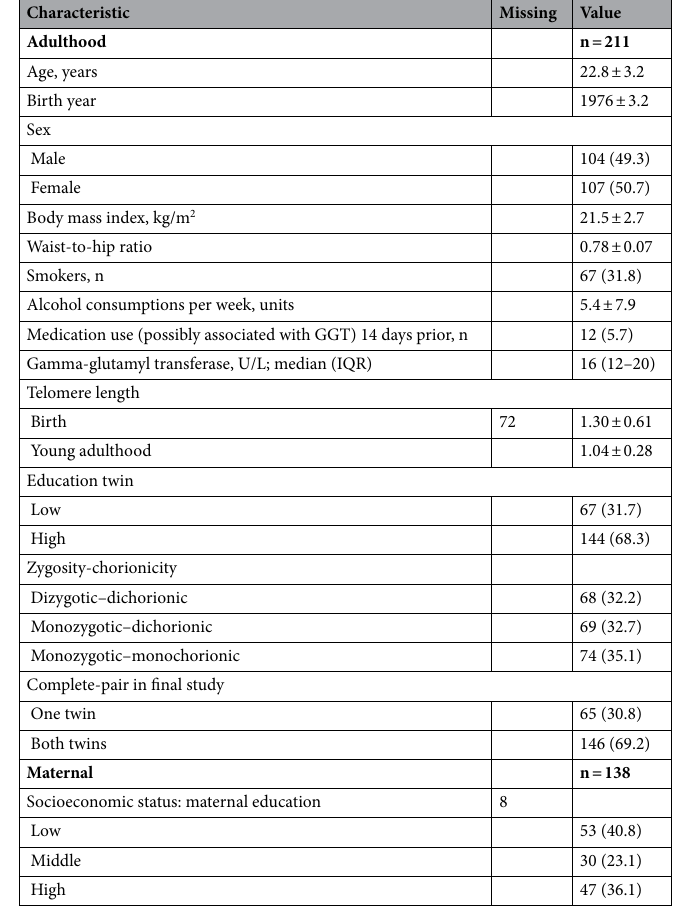
Table 1. Study population characteristics. Data presented are means ± standard deviation or number